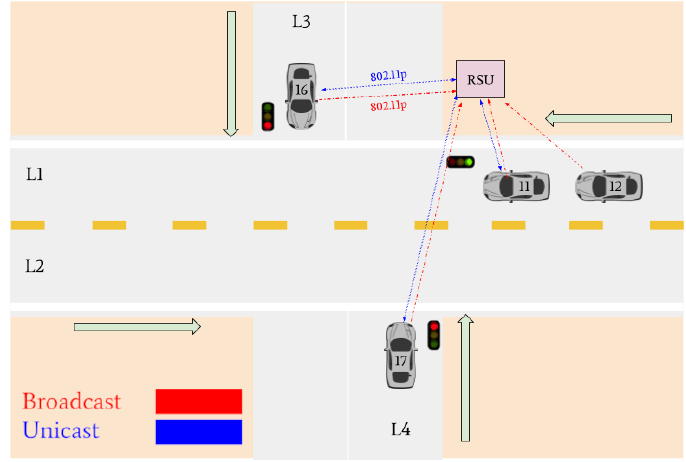
Figure 18. Vehicles 11, 16, and 17 arrive at the intersection and declare their intentions to the RSU. The RSU issues a green light to Vehicle 11 and red lights to vehicles 16 and 17. Vehicle 12 does not communicate its intentions since it is a non-lane leader.